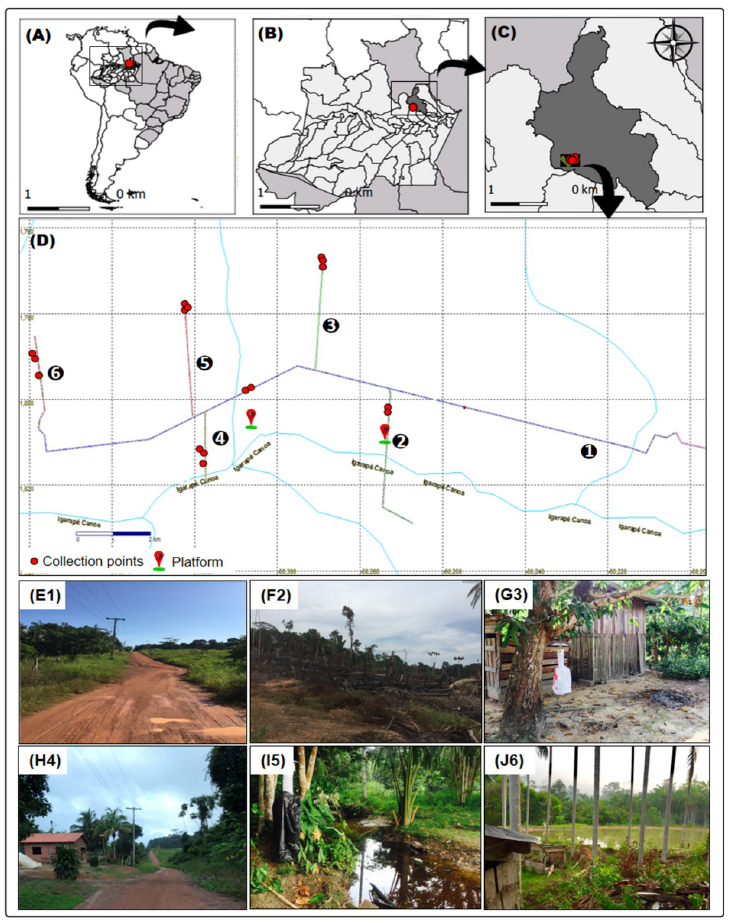
Fig 1. Map of mosquito collection area in Rio Pardo, Presidente Figueiredo, Amazonas State, Brazil. (A) South America; (B) Amazonas State; (C) Presidente Figueiredo Municipality; (D) Study area: The image shows the six branches of the community. The red dots represent the collection sites by horizontal stratification and the red and green symbols represent the platforms in the forest for collections by vertical stratification; (E1) Roads: Principal; (F2) Gusm ã o; (G3) Terra preta; (H4) Samuel; (I5) Novo Paraı´so; (J6) Taxista.